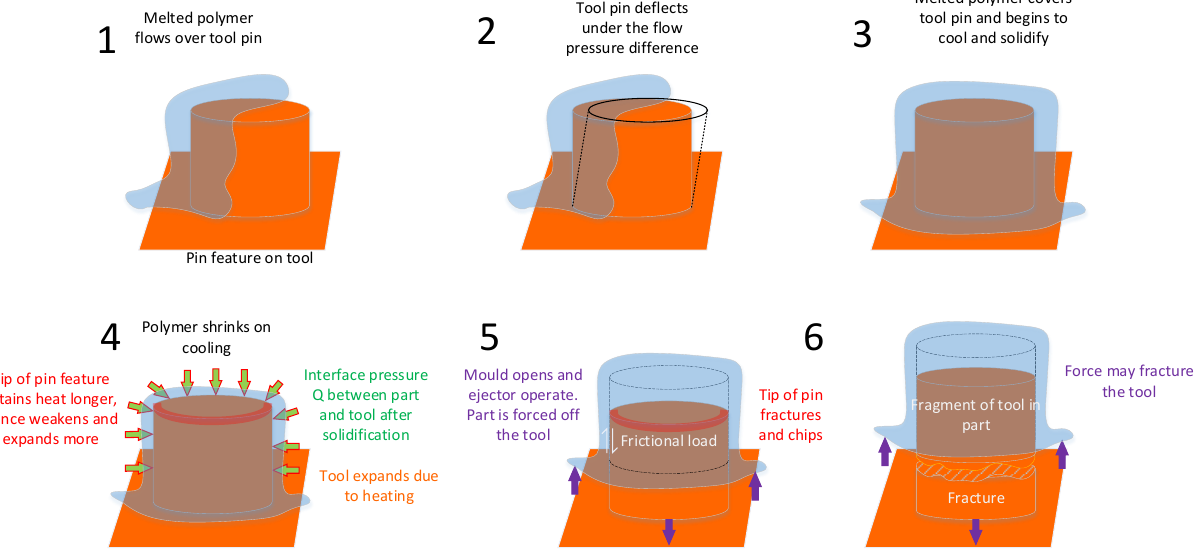
Figure 2. Graphical representation of different stages of injection moulding leading to failure.